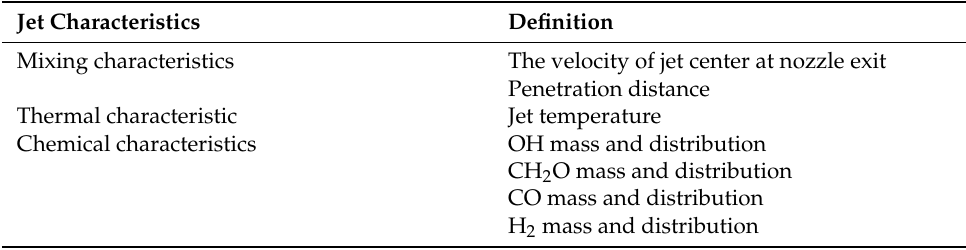
Table 3. The definition of the ignition jet characteristics.